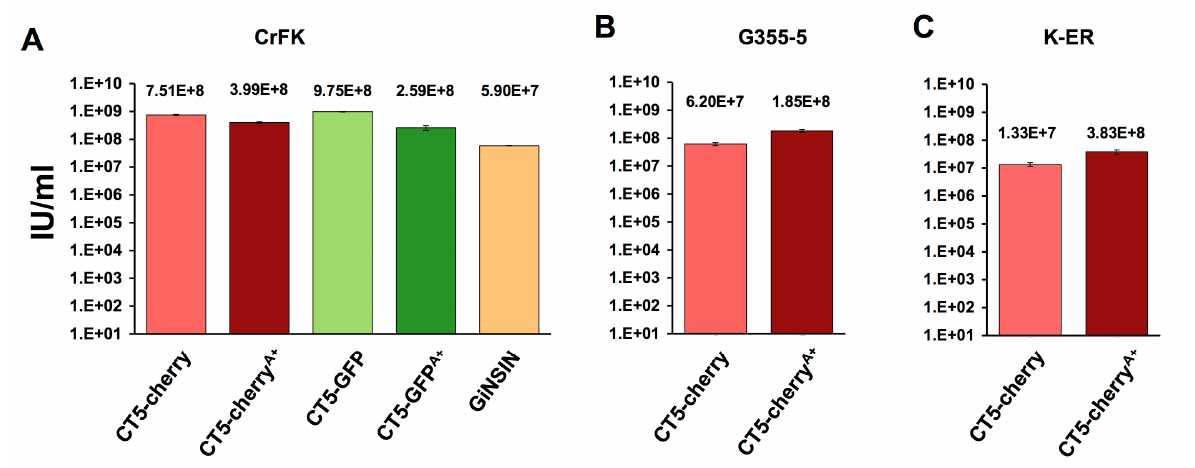
Figure 3. Reporter virus titers on (A) CrFK; (B) G355-5; and(C) FetJ cells.